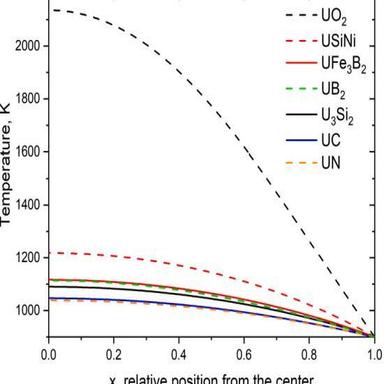
Temperature profiles of the fuel pellets calculated using Equation (, assuming a linear power density of 40,000 W m-1 and a pellet surface temperature of 900 K.